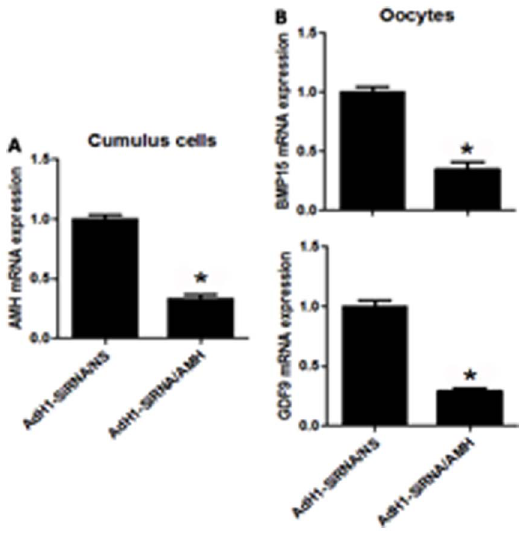
Figure 4. Effect of AMH knockdown on GDF9 and BMP15 mRNA expression from mouse cumulus cells and oocytes. Cumulus cells and oocytes were harvested from COCs infected by AdH1-SiRNA/NS or AdH1-SiRNA/AMH during IVM, respectively. (A) Shows AMH mRNA expression in cumulus cells infected by AdH1- SiRNA/NS or AdH1-SiRNA/AMH; (B) Shows GDF9 and BMP15 mRNA expressions in oocytes from COCs infected by AdH1-SiRNA/NS or AdH1- SiRNA/AMH, respectively. *Indicates significant differences (p , 0.05) compared to the control group. Data were from 3 replicates.